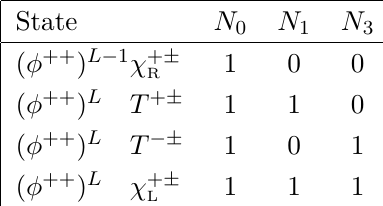
Table 5. Spin-chain configurations with a single massless excitation and the corresponding exci- tation